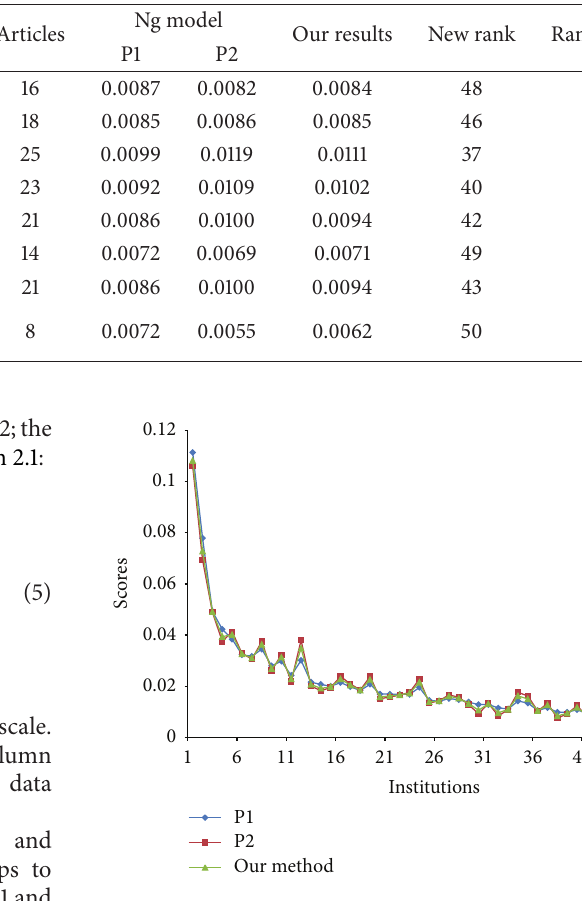
Figure 1: Comparisons among P1, P2, and our